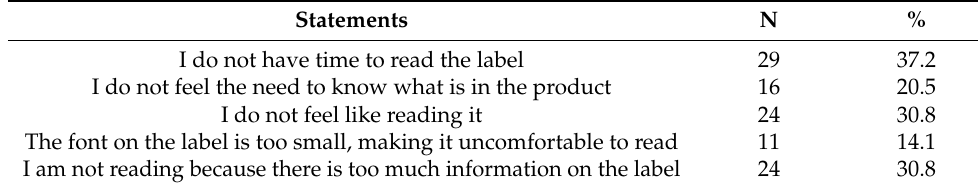
Table 2. Reasons for not reading label information (N; %).